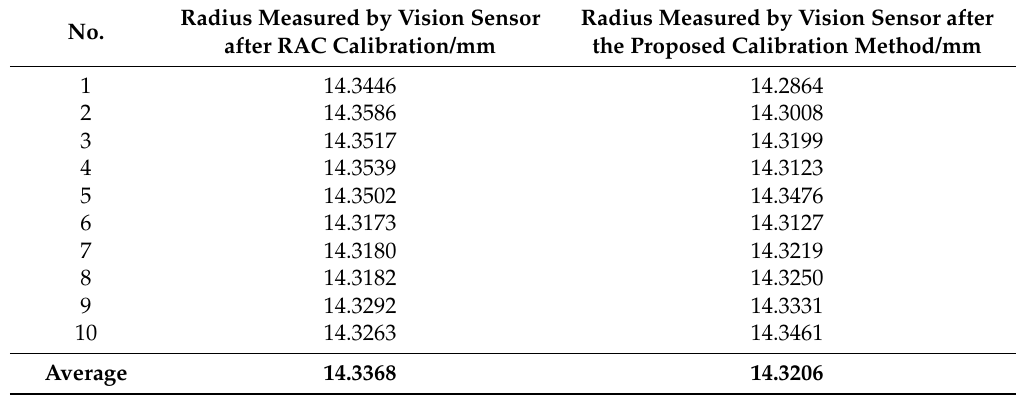
Table 3. Experimental result (for the standard ball